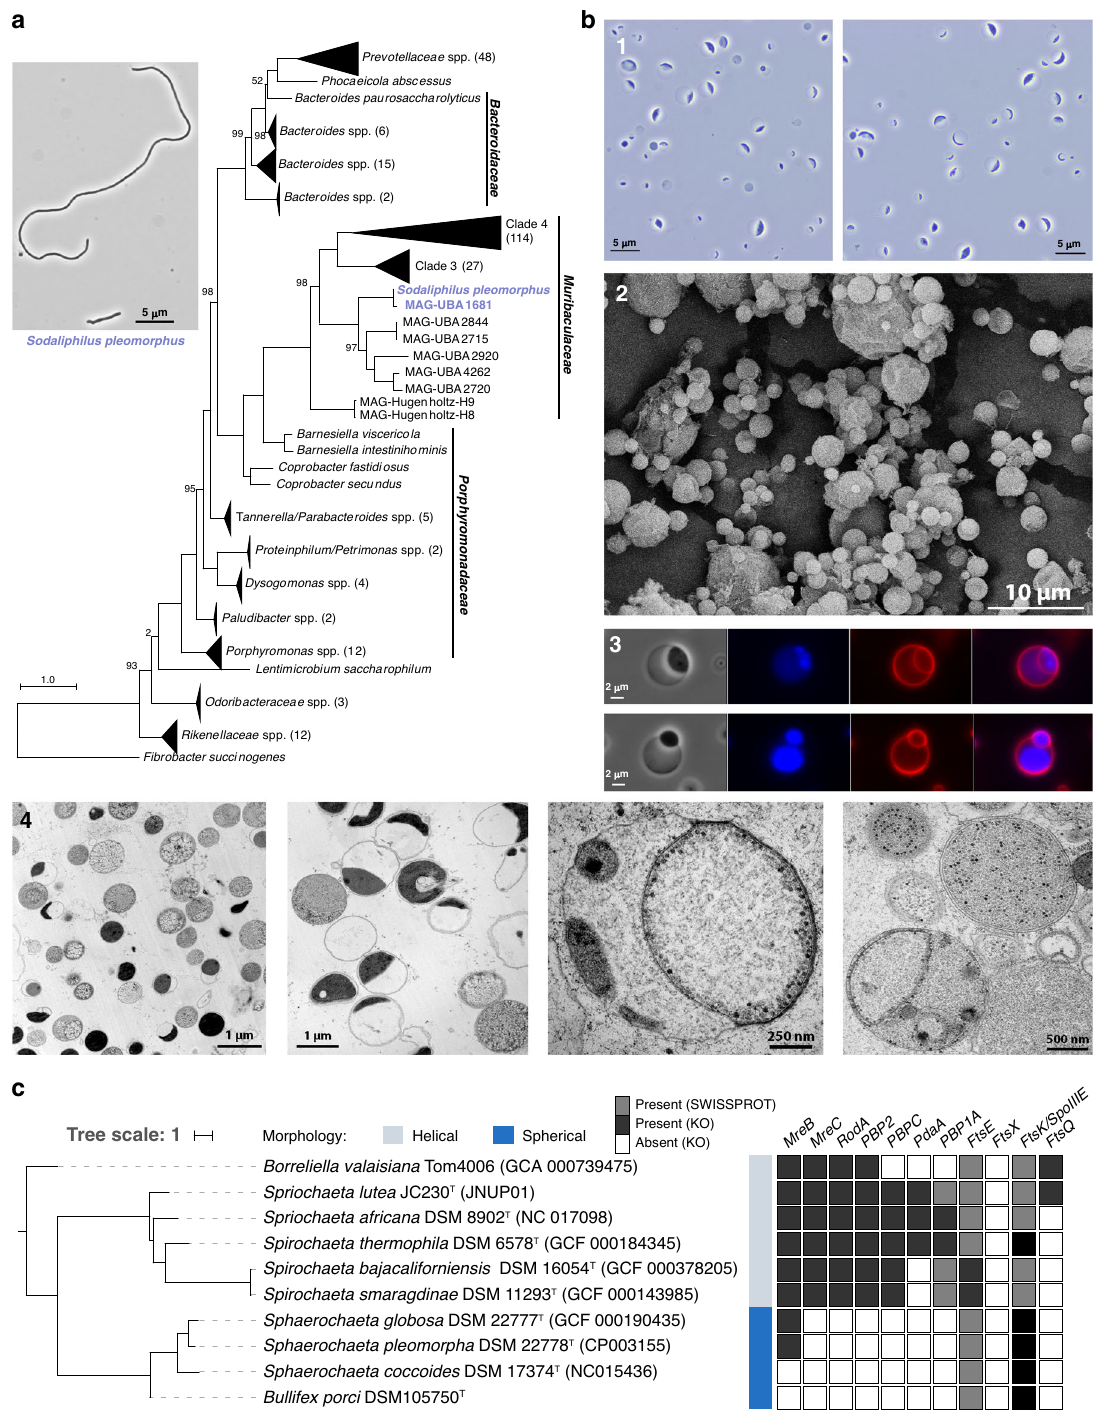
Towards new bacterial functions . Genome-based mapping of the collection on KEGG pathways is shown in Supplementary Fig. 12. As antibiotics are a matter of concern in pig farming, data on the occurrence of antimicrobial resistance genes are sum- marized in Supplementary Data 1 and Supplementary Fig. 2b. The overall EggNOG-derived functional pro fi le of all isolates indicated that nearly 25% of annotated proteins have unknown functions (Supplementary Fig. 2c), stressing the need to perform in-depth functional studies on cultured microbes. We therefore sought to highlight novel functions within